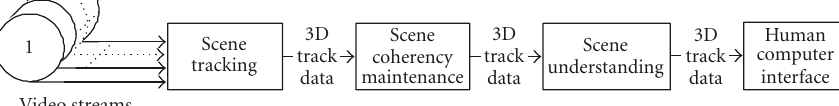
Figure 2: The AVITRACK system.